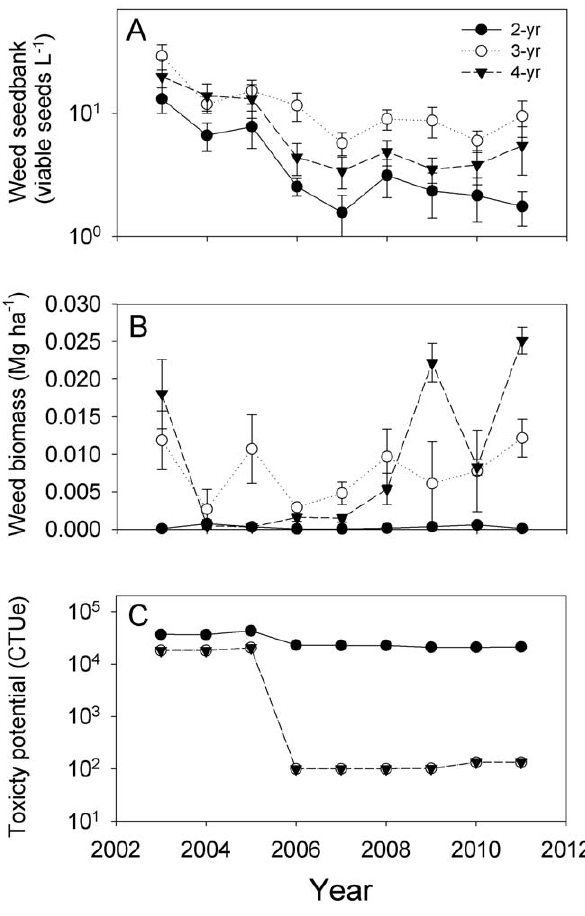
Figure 2. Divergent weed management systems. Weed manage- ment characteristics in maize-soybean (2-yr), maize-soybean-small grain/red clover (3-yr), and maize-soybean-small grain/alfalfa-alfalfa (4- yr) cropping systems in Boone, IA, from 2003 to 2011. Performance metrics included a) weed seed density in soil, b) weed aboveground biomass, and c) freshwater toxicity potential expressed in comparative toxic units (CTU e ). Symbols represent the mean 6 SEM of four replicate experimental blocks (N=36 per cropping system).